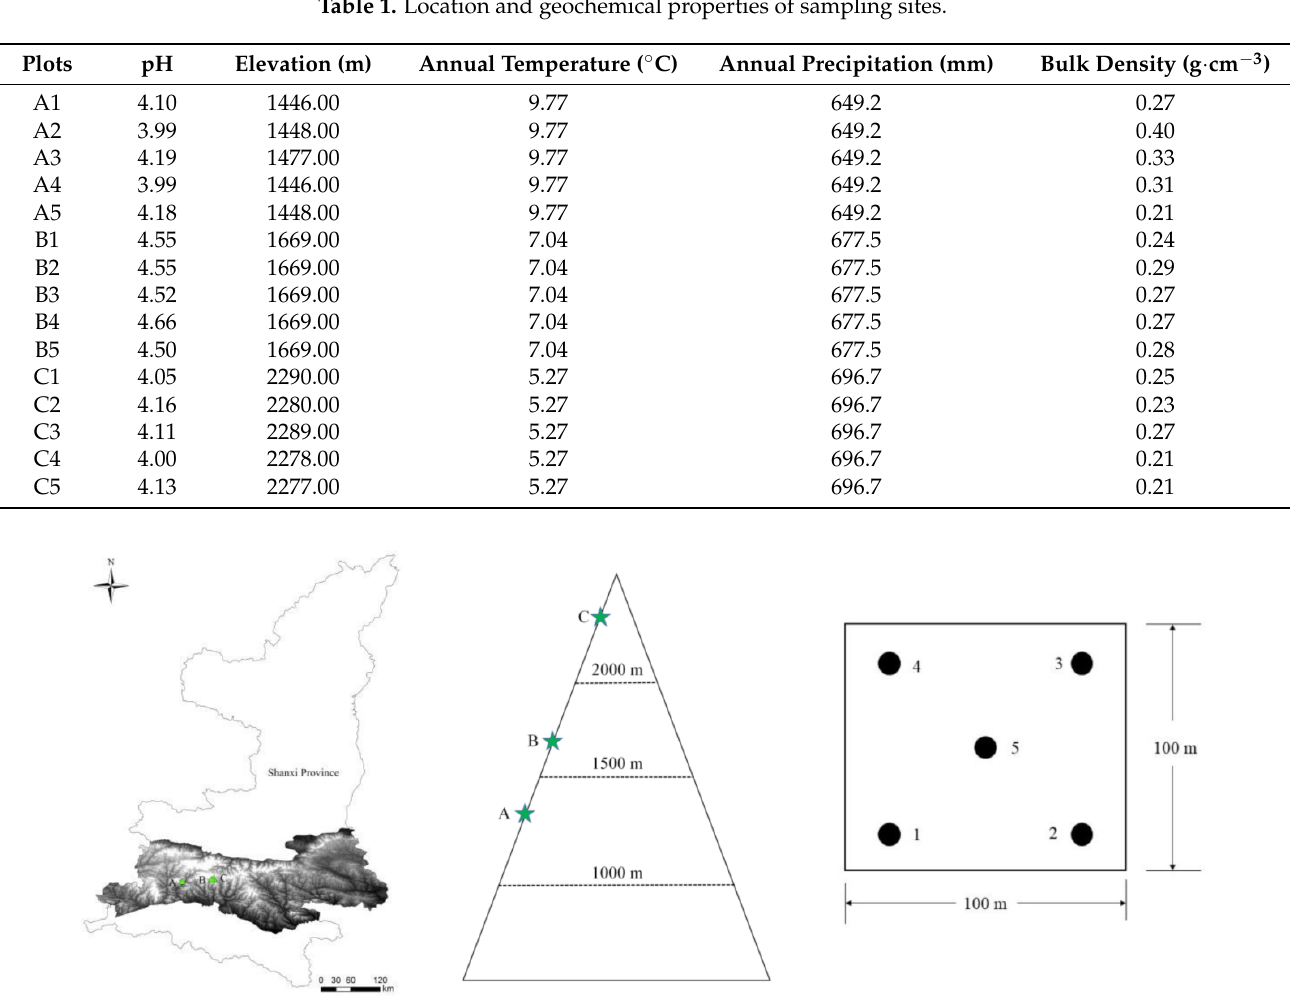
Table 1. Location and geochemical properties of sampling sites.